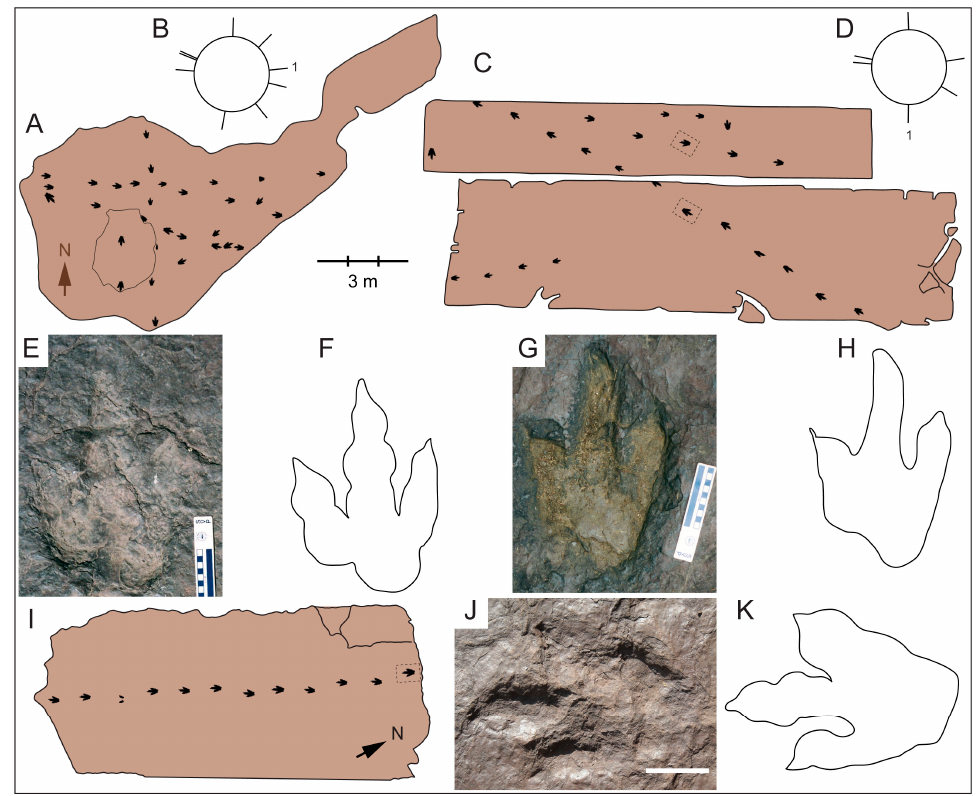
Figure 3. Eubrontes giganteus tracks, trackways, and orientations from the William Murray quarry, in Holyoke, Massachusetts. ( A ) Sketch map of the in situ surface; ( B ) Rose diagram of track and trackway orientations on the in situ surface; ( C ) Sketch map of the Forest Park (bottom) and Wistariahurst Museum (top) slabs; ( D ) Rose diagram of the orientations of the tracks and trackways on the slabs; ( E , F ) photograph and line drawing, respectively, of a 12 mm deep track boxed on the map of the Wistariahurst Museum slab; ( G , H ) photograph and line drawing, respectively, of a 30 mm deep track boxed on the map of the Forest Park slab; ( I ) Sketch map of a portion of the Gary Gaulin Dinosaur Tracksite showing the isolated trackway on that bed; ( J , K ) photograph and line drawing, respectively, of the track boxed in ( I ). Sketch maps are to scale. Scale bars in ( E , G ) are in cm; that in ( J ) is 10 cm.